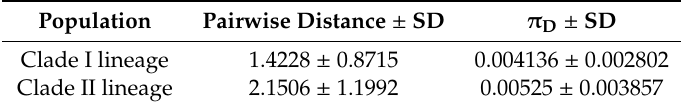
Table 6. Genetic distance and nucleotide diversity of the two clades.